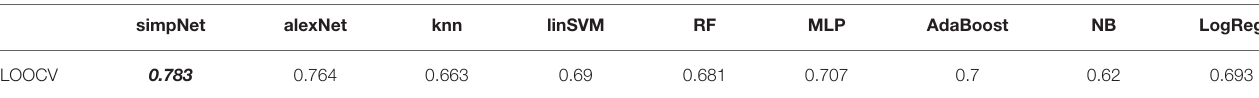
TABLE 4 | Switch-task results, task-generalization: Average classification accuracies over all participants if the classifier was trained in using a LOOCV for each task in the switch dataset; bold and italic , highest average accuracy; bold , p -value of the one-sided Wilcoxon Signed Rank Test above 0.05, thus no statistical difference between this and the best performing